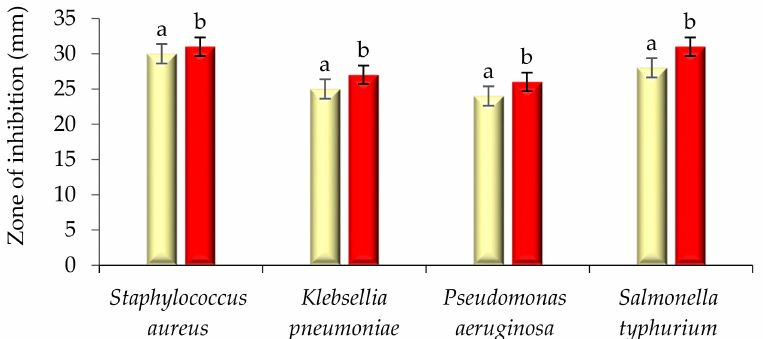
Figure 3. Antibacterial activity (zone of inhibition) of Woodfordia fruticosa flower’s dry extract and antibiotic streptomycin against Gram-positive and Gram-negative bacteria. Data are presented as means ± SEM ( n = 3); a, b: Means within the column with different lowercase superscripts are significantly different ( p < 0.05).